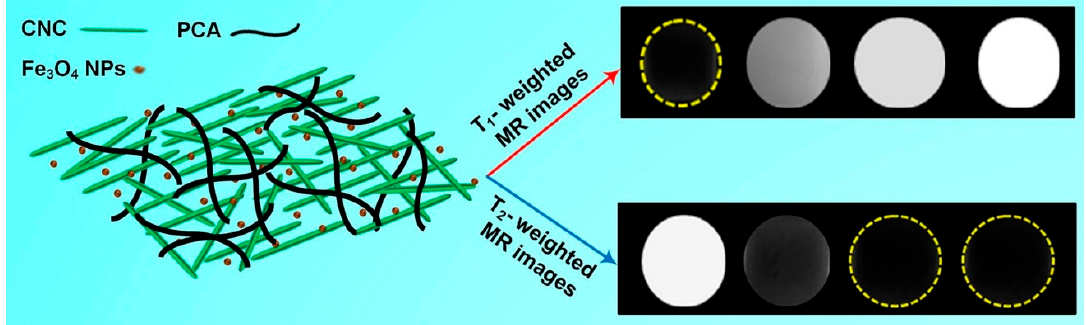
Figure 9. Schematic representation of the CNC-PCA/Fe 3 O 4 structure; T1- and T2-weighted MRI images of CNC-PCA/Fe 3 O 4 at increasing (left to right) Fe concentrations (0, 0.1, 0.3, 0.5 mM)